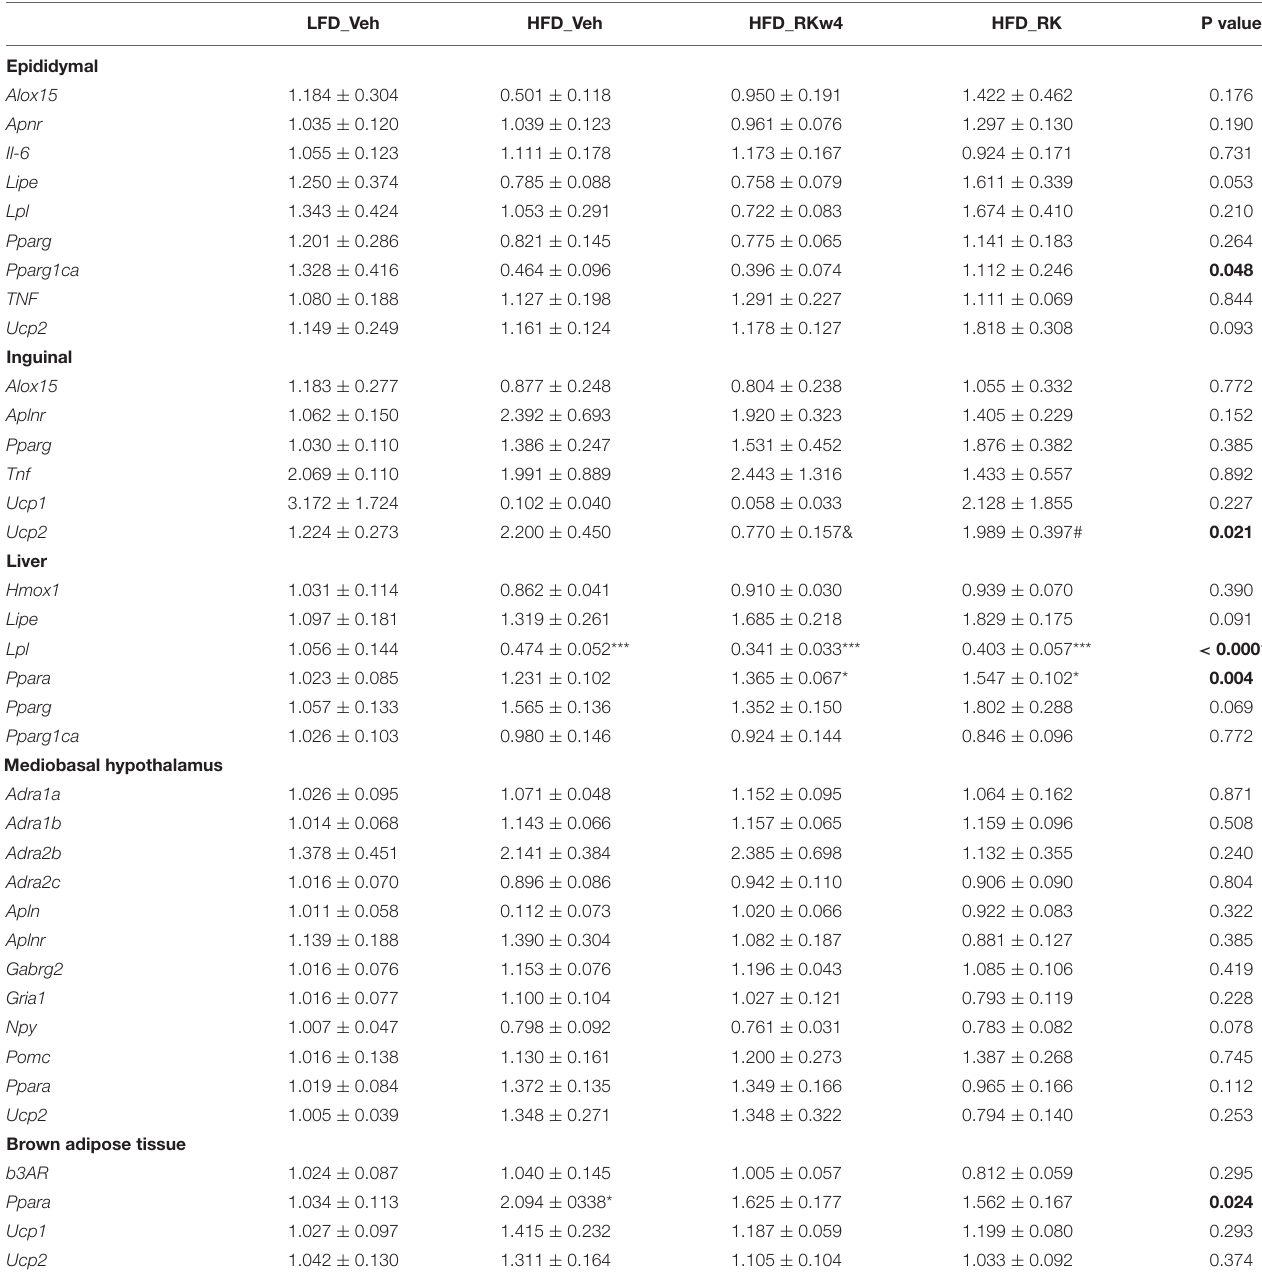
TABLE 1 | Gene expression in white adipose tissue, brown adipose tissue, liver, and